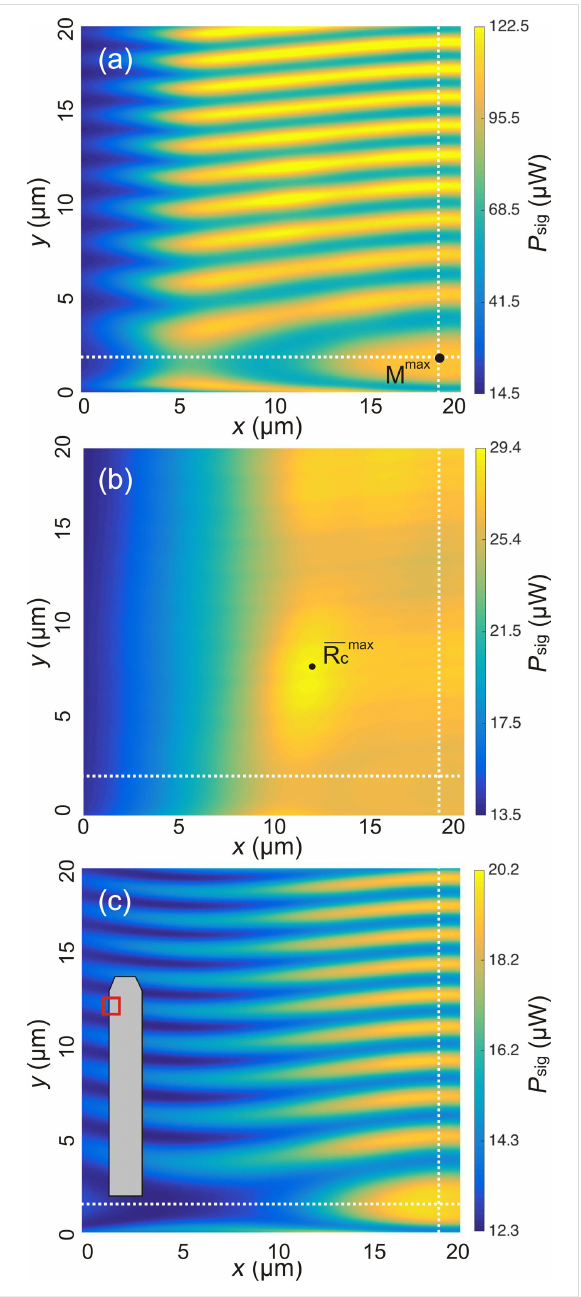
Figure 6: Lateral interference patterns for cantilever 4 scanned by the fiber-positioning piezo for (a) Fabry–Pérot interference d = 25 μ m, (b) interferometric quenching at d = 300 μ m and (c) Michelson interfer- ence at d = 500 μ m. The inset shows a sketch of the scanned area in relation to the cantilever. For a full account of the interference pattern, see Supporting Information File